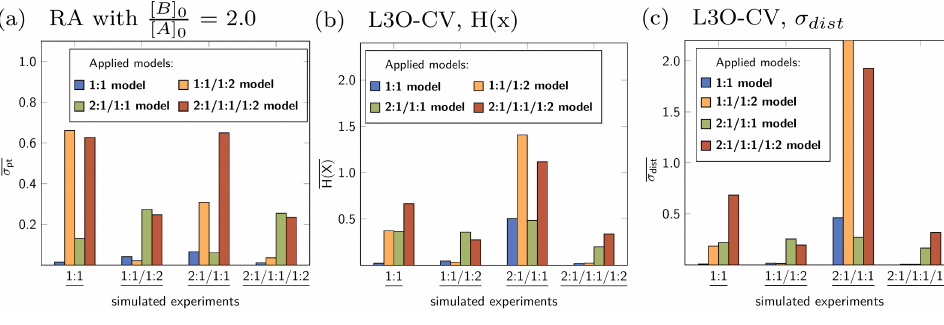
Figure 12 (A–C) Model-wise average of the statistical descriptors calculated for each model using the model parameters for a given simulated titration experiment. In case of the fitted 1:1/1:2 model on top of the simulated 2:1/1:1 experiment, a value σ dist around 11 was obtained.